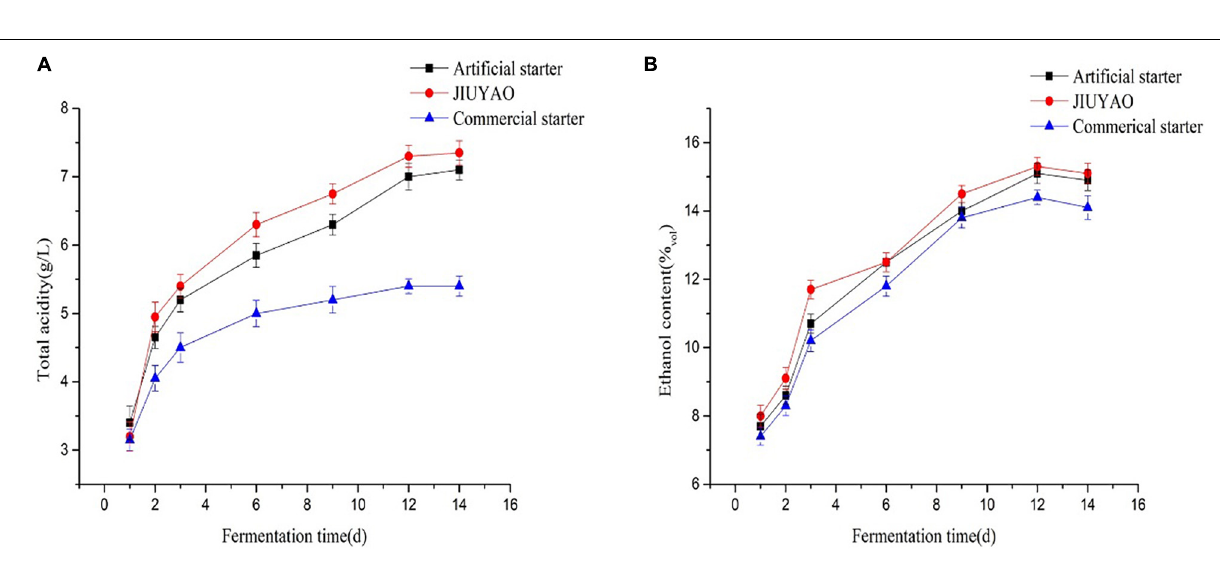
Frontiers in Microbiology |